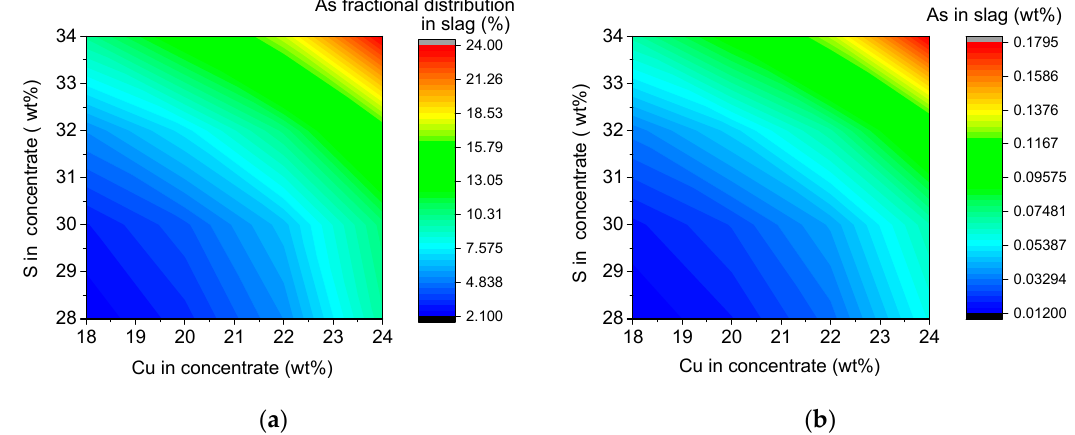
Figure 6. Arsenic distribution in the slag phase: ( a ) fractional distribution; ( b ) mass fraction.